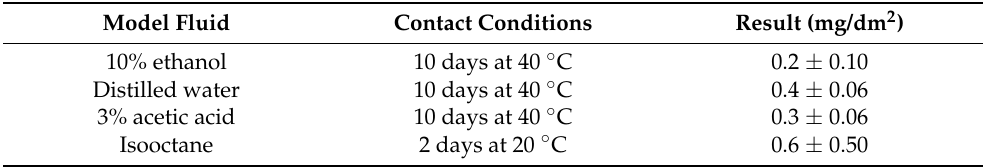
Table 3. Global migration test results for LDPE containing 4% biocide in accordance with EN 1186-1:2015 (acceptability criterion ≤ 10 mg/dm 2 ).